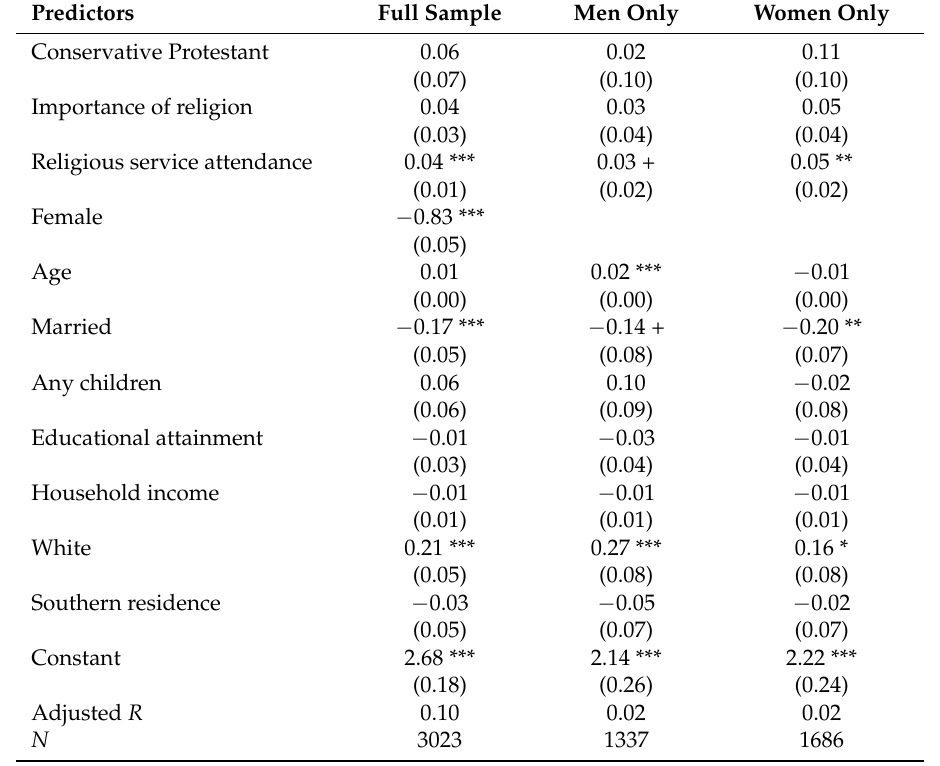
Table 2. Ordinary least squares regression predicting how much a respondent attributes their most recent divorce to their former spouse’s